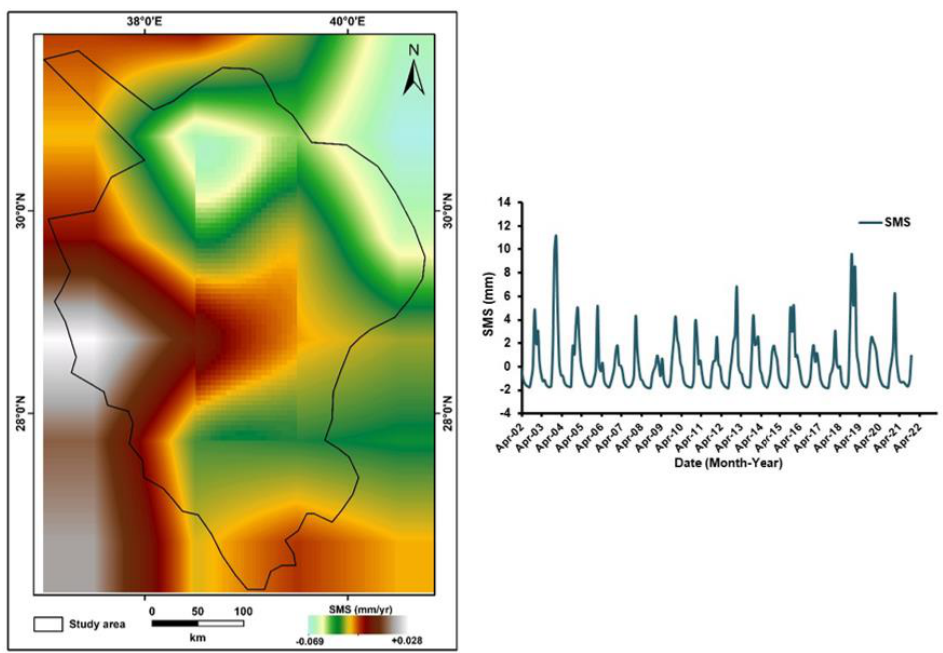
Figure 6. Spatiotemporal distribution and the monthly time series of the SMS trend for the entire study area.